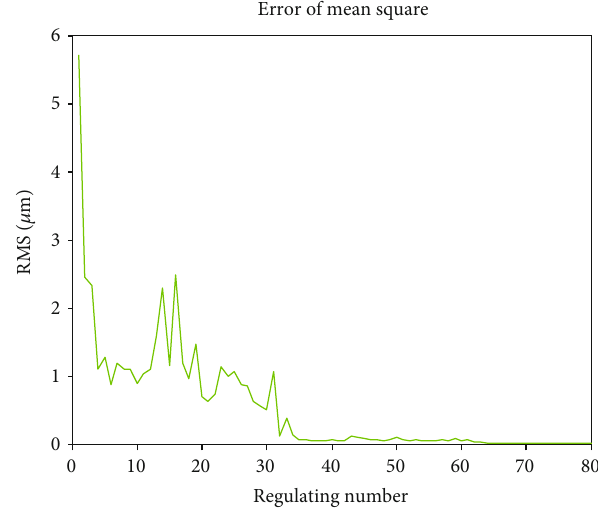
Figure 5: Root mean square (RMS) based on 25